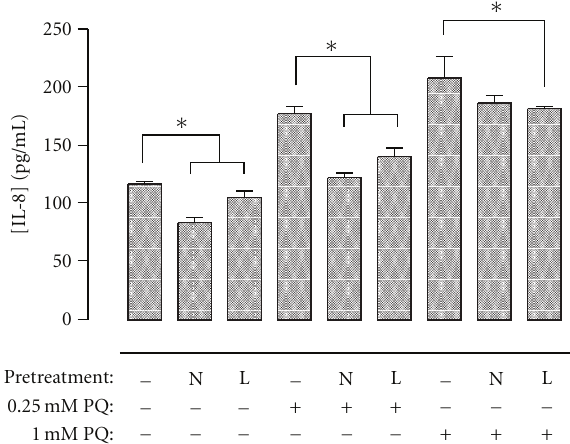
Figure 4: E ff ect of NAC or L-NAC pretreatment on mitochondrial membrane potential following PQ challenge. Cells pretreated for 4h with control media or 5.0 mM NAC- (N) or L-NAC-containing media (L) were challenged with 0, 0.25, or 1.0mM PQ for 4h. Cells were stained for 30min posttreatment with the cell permeable JC- 1 fluorescent dye. Bars represent mean ± S.E.M. of 3 independent experiments. ∗ denotes significant di ff erence relative to cells with no pretreatment ( P < . 05).